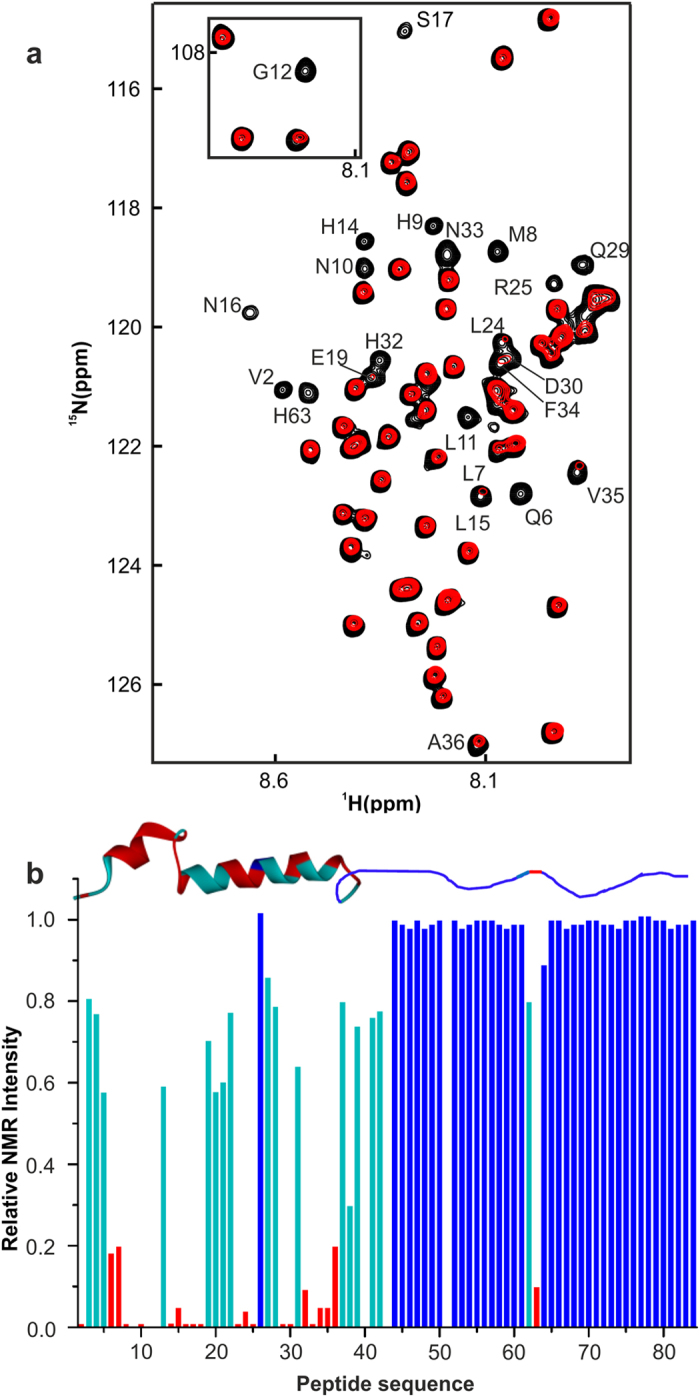
Binding profile of the Zn complex toward the PTH(1–84).(a) 2D 1H–15N HSQC overlaid spectrum of 15N PTH(1–84) in the free state (black) and bound to the Zn complex (red). (b) Residue by residue relative NMR intensity plot of 15N PTH(1–84) in the bound state with Zn complex compared to free 15N PTH(1–84). Residues lost >80% of intensity are marked red, 50–20% losses are given in cyan and no significant change in blue. The structure of PTH(1–84) (structure of residues 1–39, PDB: 1BWX)63 is displayed above the intensity plot. No bars are given for the prolines at positions 40, 43 and 51.